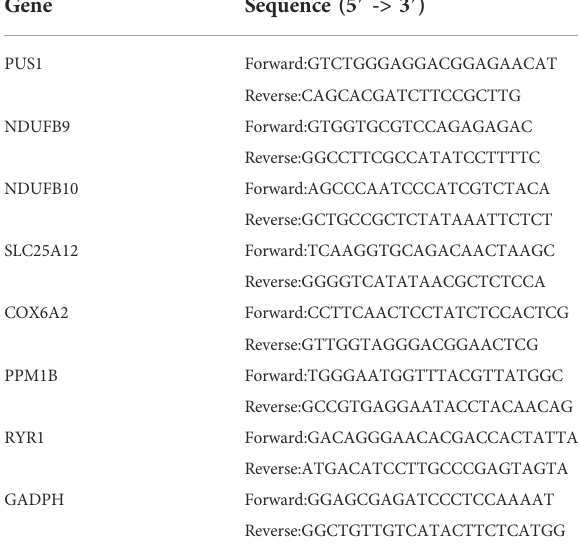
TABLE 1 The primer sequences of the candidate